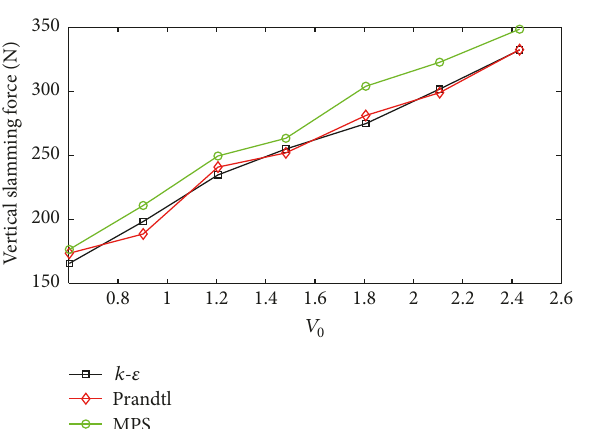
Figure 17: Vertical slamming force of vertical water entry. Figure 18: Vertical slamming force of water entry with angle 9.8